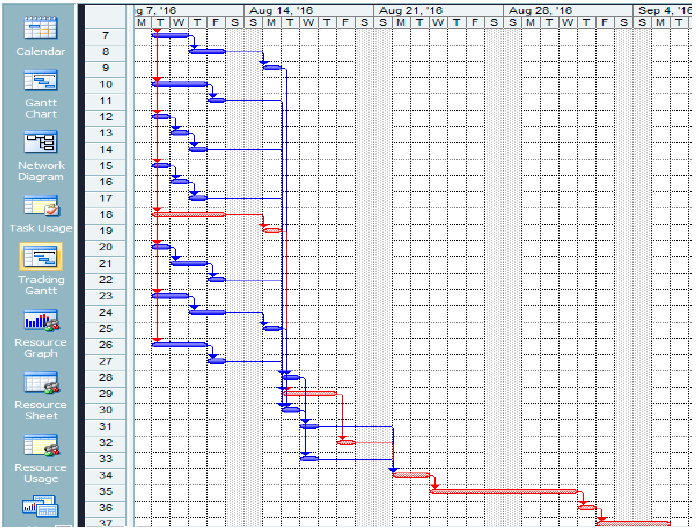
Figure 4. Illustrative part of gantographic display of the project to improve the environmental protection system in mining and energy complexes.